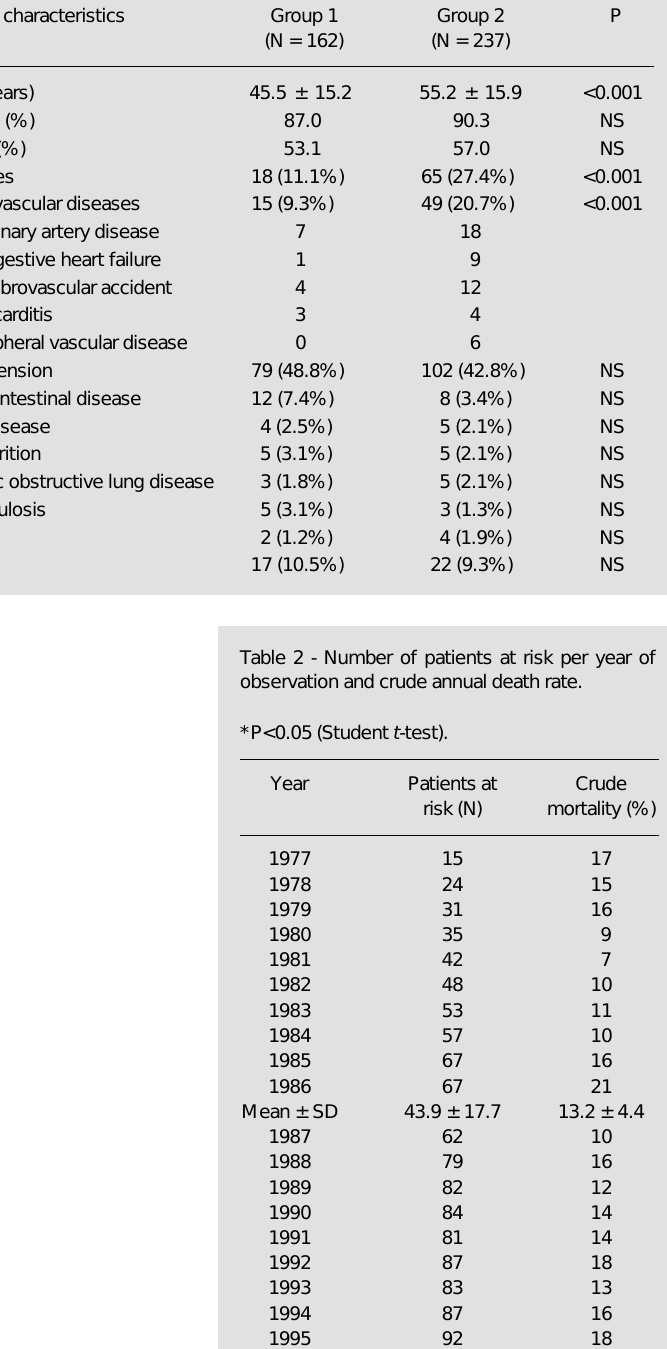
Table 1 - Clinical characteristics of the patients in the present study. NS, Nonsignificant. The Student t - and chi-square tests were used to compare groups. Clinical characteristics